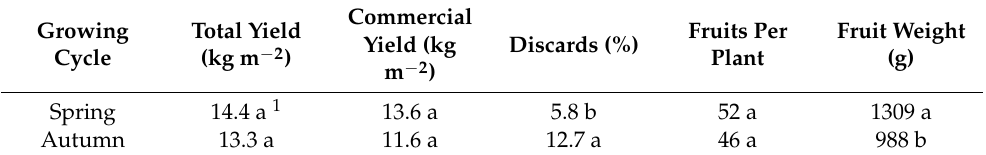
Table 2. Total and commercial yield, discards, fruit number per plant, and fruit weight in ‘Intenzza’ papayas grown in spring versus autumn planting season.